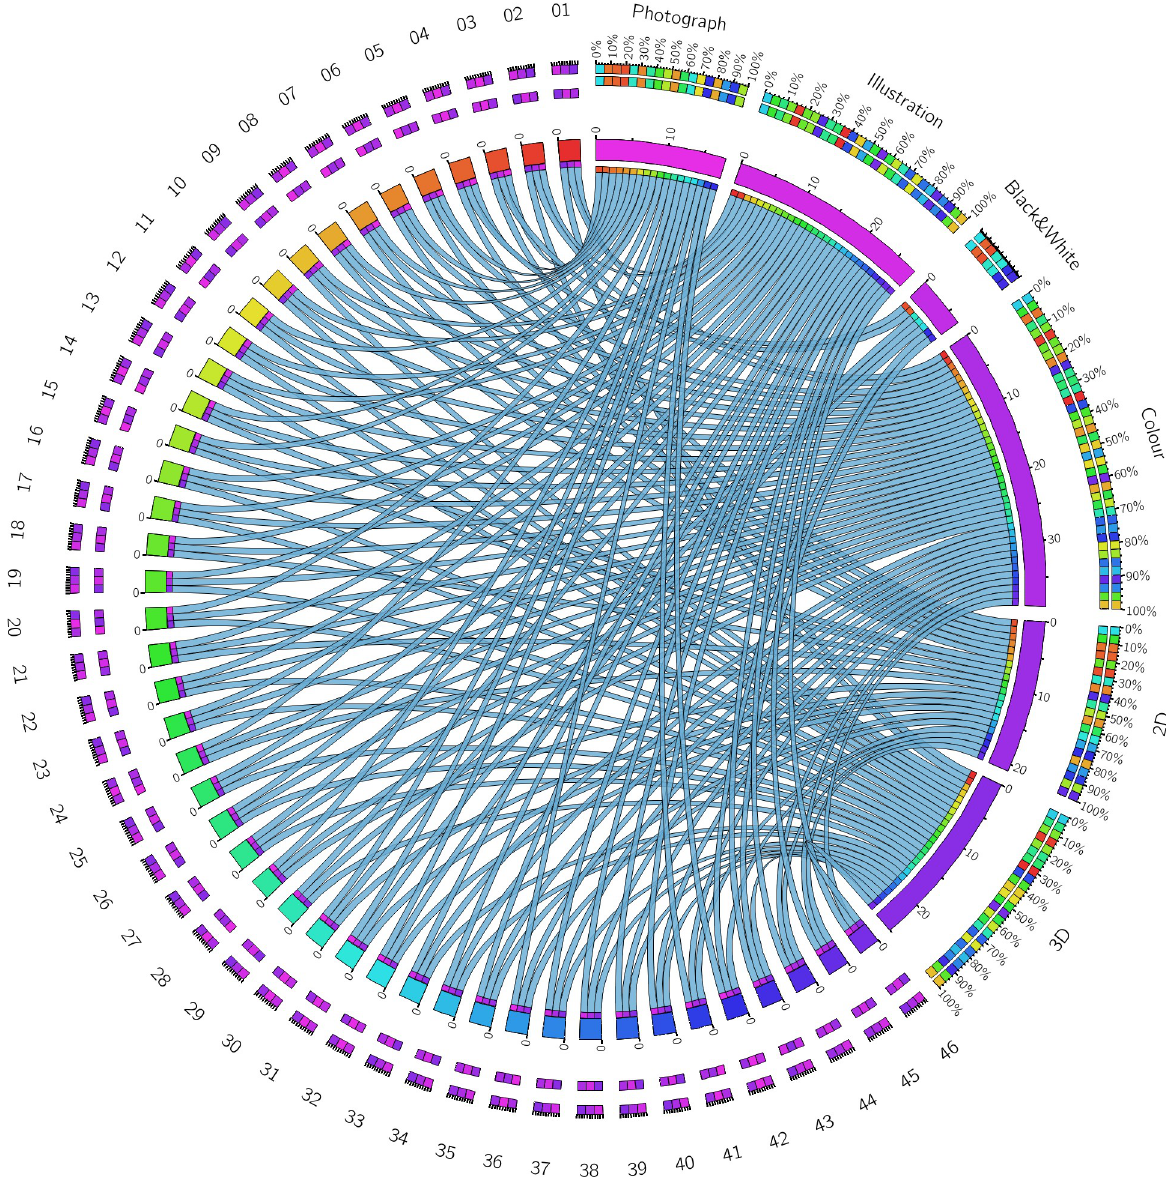
Fig 3. Chord diagram of the attributes of the images presented. Each number corresponds to one of the images. Each string indicates the connection between the image and its attributes, and the colours are used for ready visualization. The percentages and squares in the outer ring show the number of images needed to get a specific percentage for each attribute. Note there were fewer black and white images.